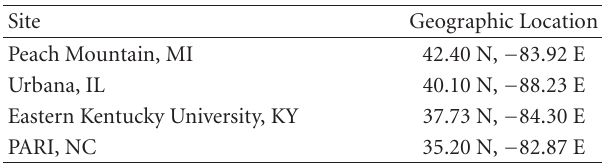
Table 2: Geographic location of four initial sites to be deployed for NATION.